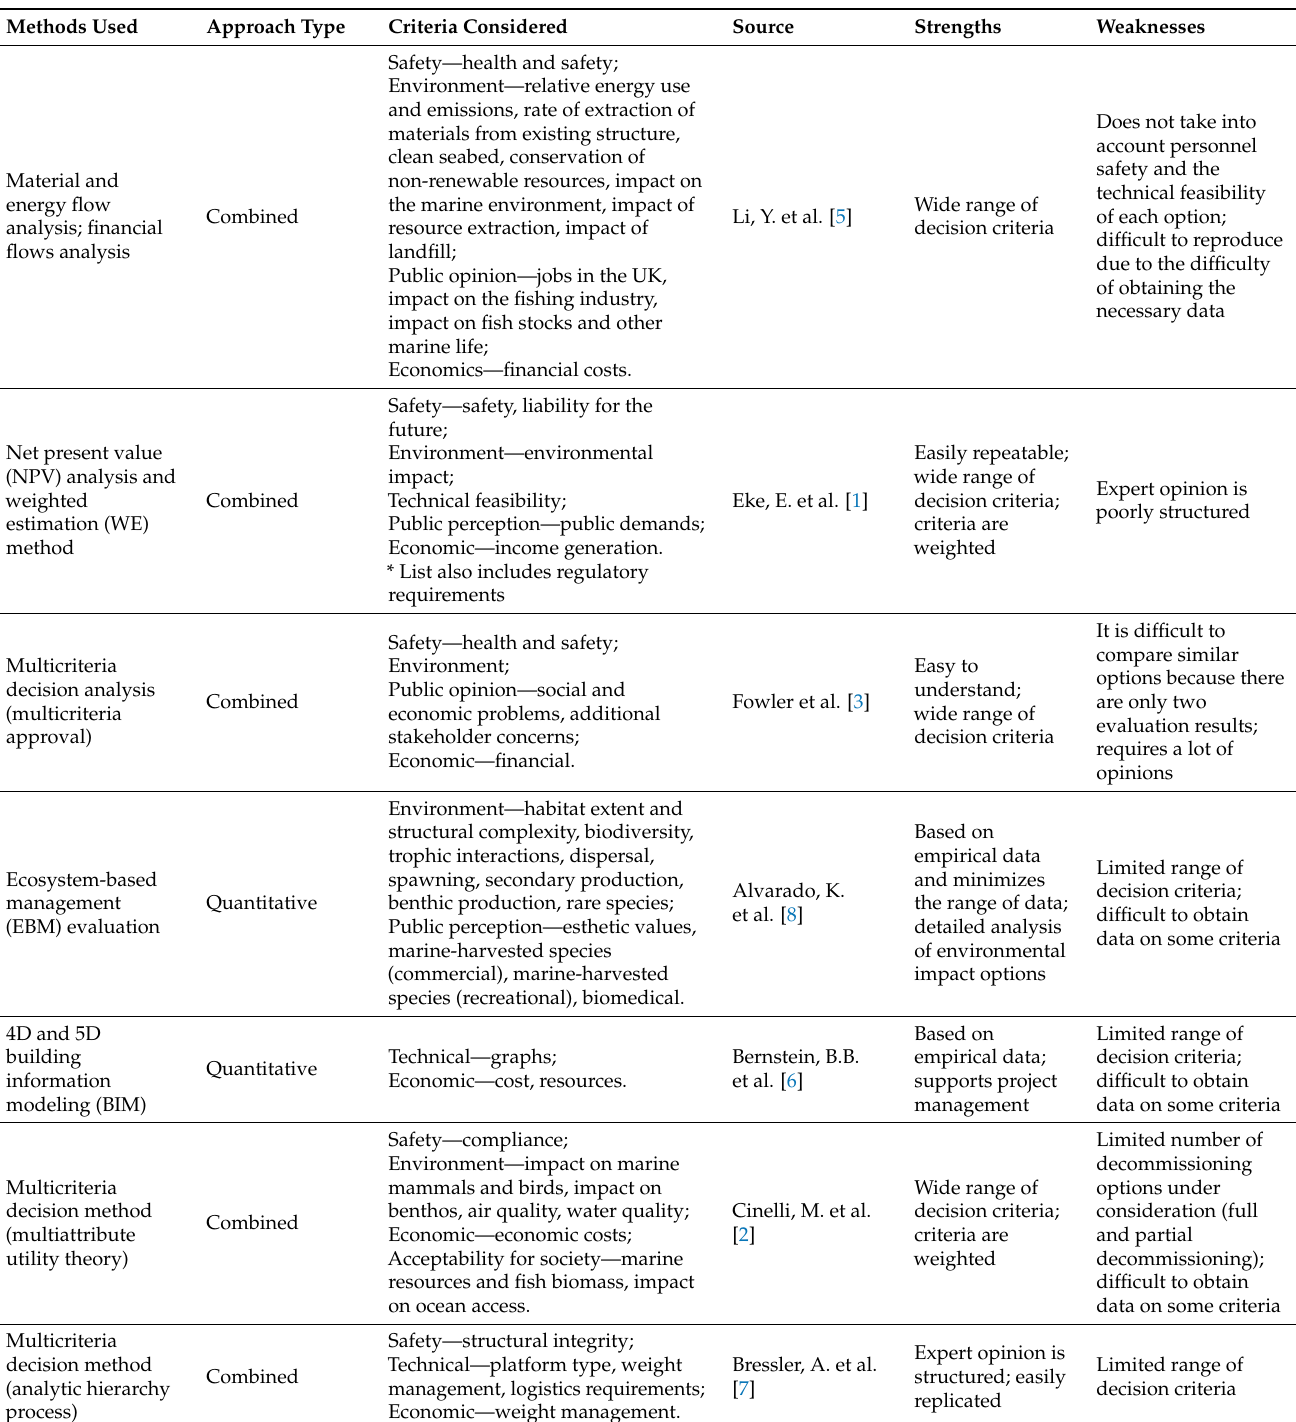
Table 3. Existing approaches to optimize decommissioning